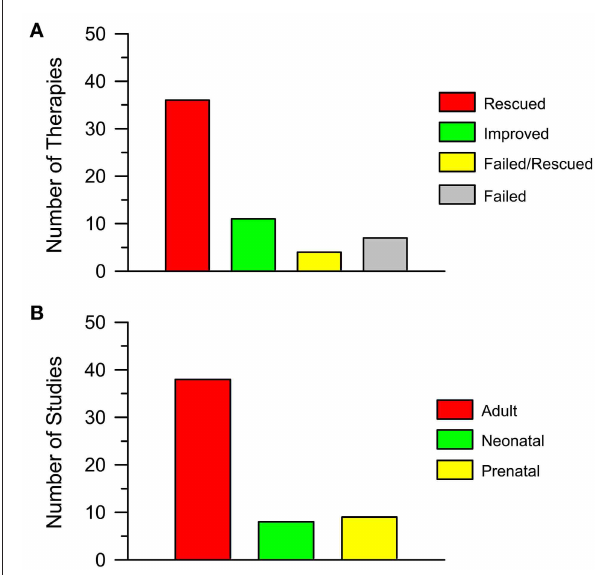
FIGURE 3 | Pharmacotherapies in the Ts65Dn mouse model of Down syndrome. (A) The histogram shows the number of attempted pharmacotherapies in the Ts65Dn mouse model of DS that rescued (Rescued), improved (Improved), partially rescued (Failed/Rescued) the examined phenotype/s or had no effect (Failed). Data derive from Tables 1 , 2 . (B) The histogram shows the number of studies in which pharmacotherapies